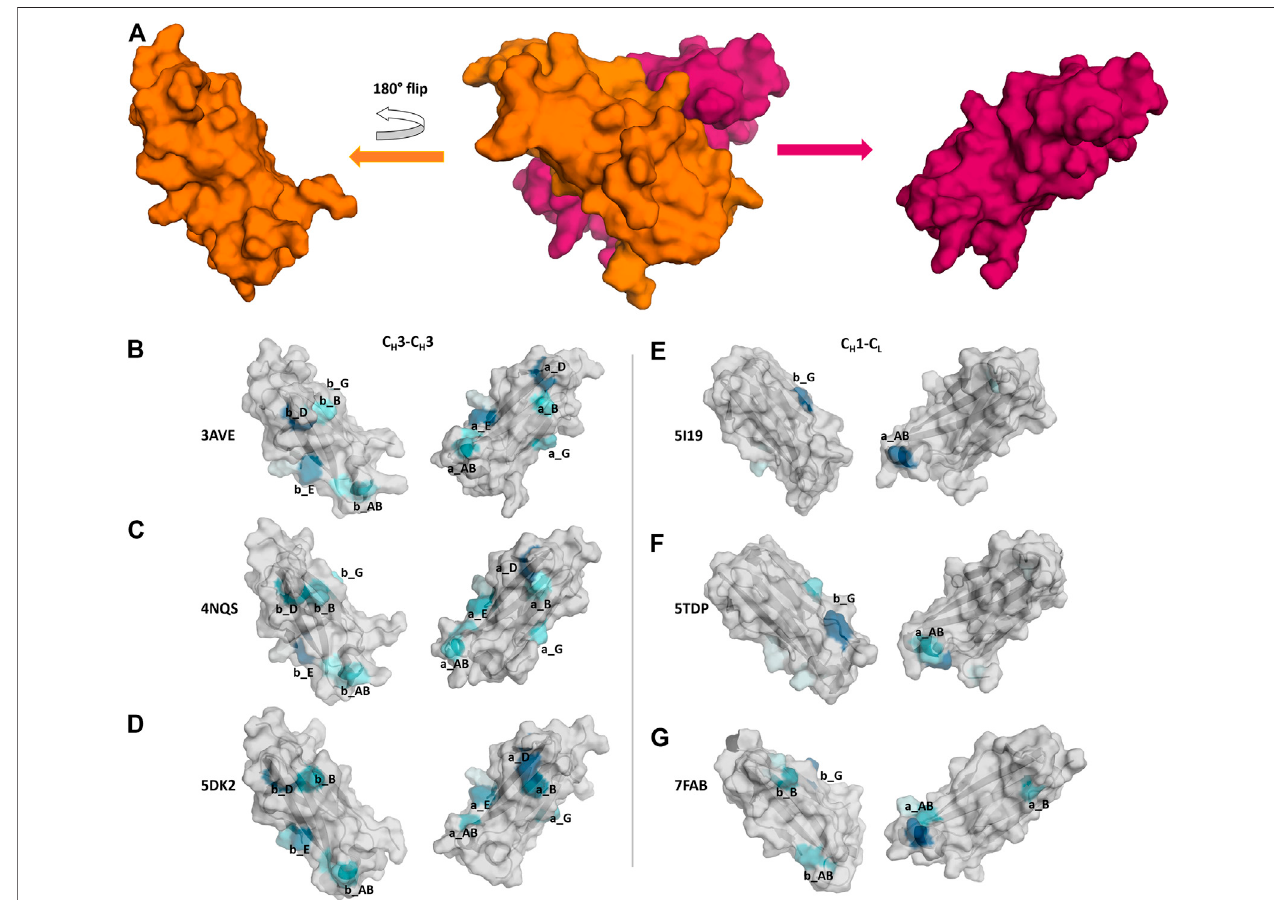
FIGURE7| ComparisonofC H 3-C H 3andC H 1-C L interfaceinteractionpatternsbyanalyzingtheirsaltbridgeinterdomaininteractions. (A) Stepwiseillustrationofthe work fl ow to obtain the “ open-book ” representation (PDB: 3AVE). (B – G) Each individual domain is gradually colored based on the number and duration of interdomain interactions. The color-gradient (grey to blue) corresponds to the number of interdomain salt bridges each residue is forming (the higher the number of contacts, the darker are the shades of